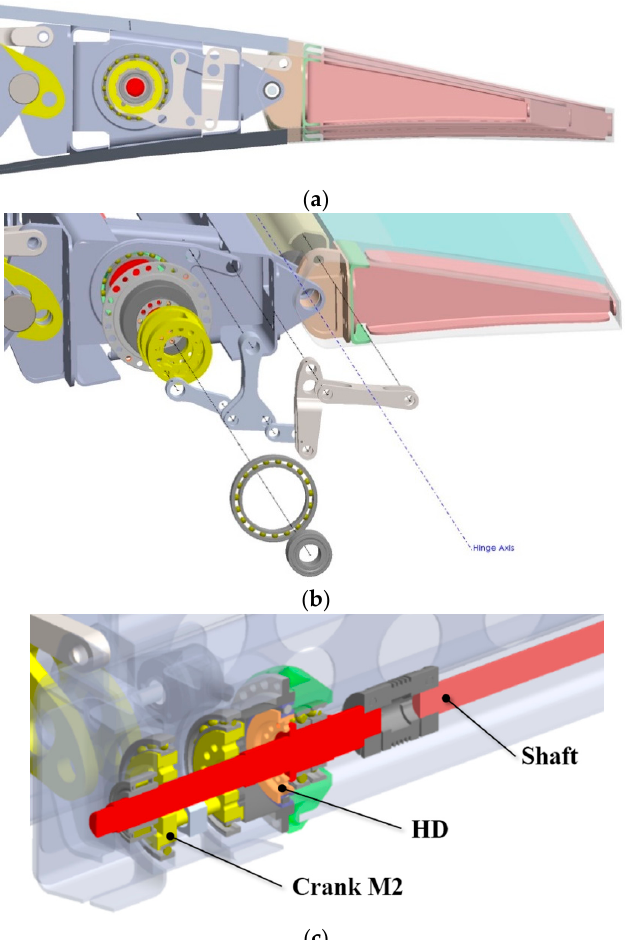
Figure 13. Mechanical Arrangement of the Inner Mechanism: ( a ) Leverage within the available design space in the wing tip section, 3D-CAD (side-view); ( b ) 3D-CAD exploded view; ( c ) section view.